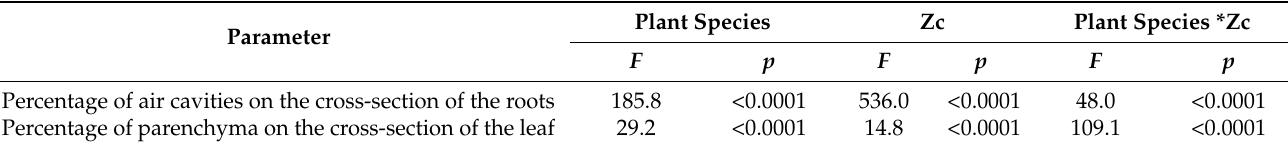
Table 4. Effects of the plant species characteristics and pollution level according to the integral pollution index (Zc) on microstructural characteristics of cattails as indicated by factorial ANOVA.